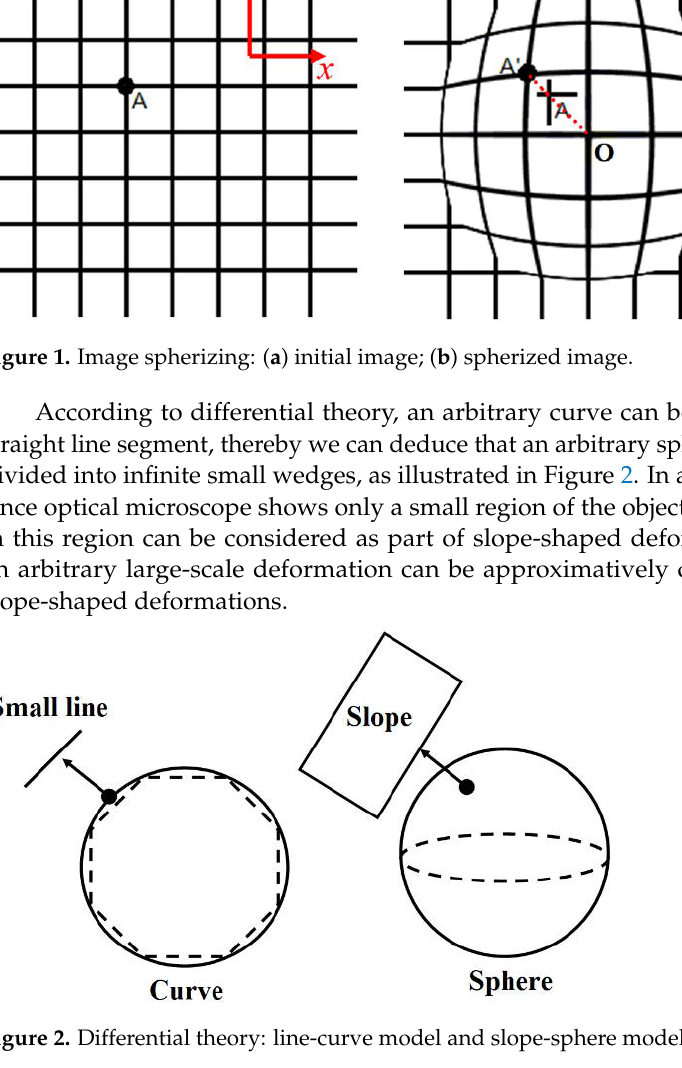
Figure 2. Differential theory: line-curve model and slope-sphere model.